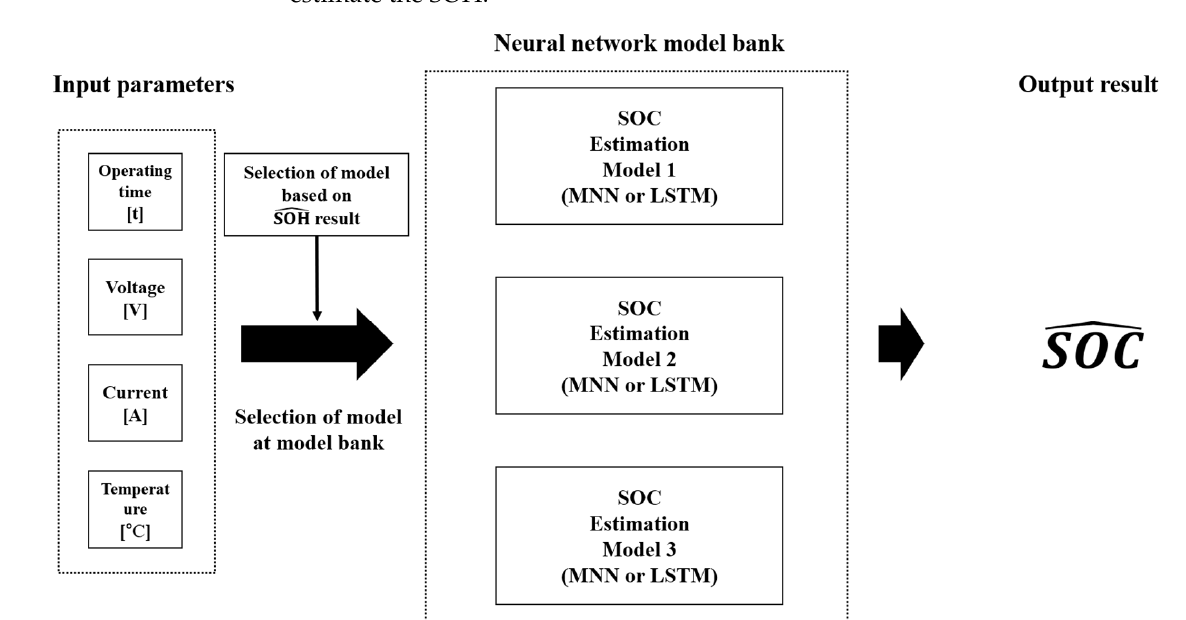
Figure 2. Structure of SOH estimation method.